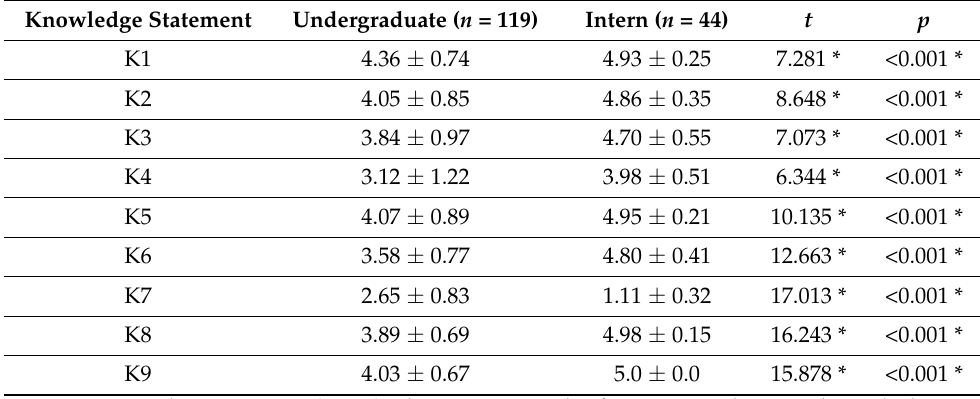
Table 5. Comparison of undergraduate students and interns according to their responses for the scoring of their knowledge statement